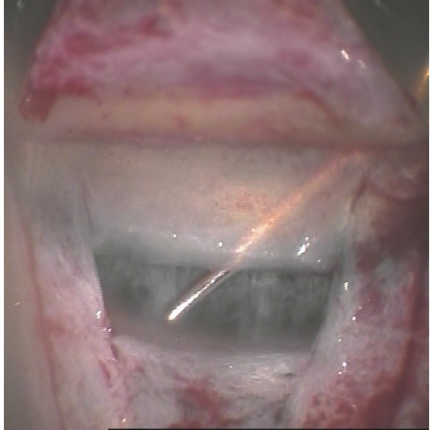
Figure 1: Goniosynechiolysis ab interno using a spatula introduced through paracentesis. Full visual control is attained through the peripheral trabeculo-Descemet’s